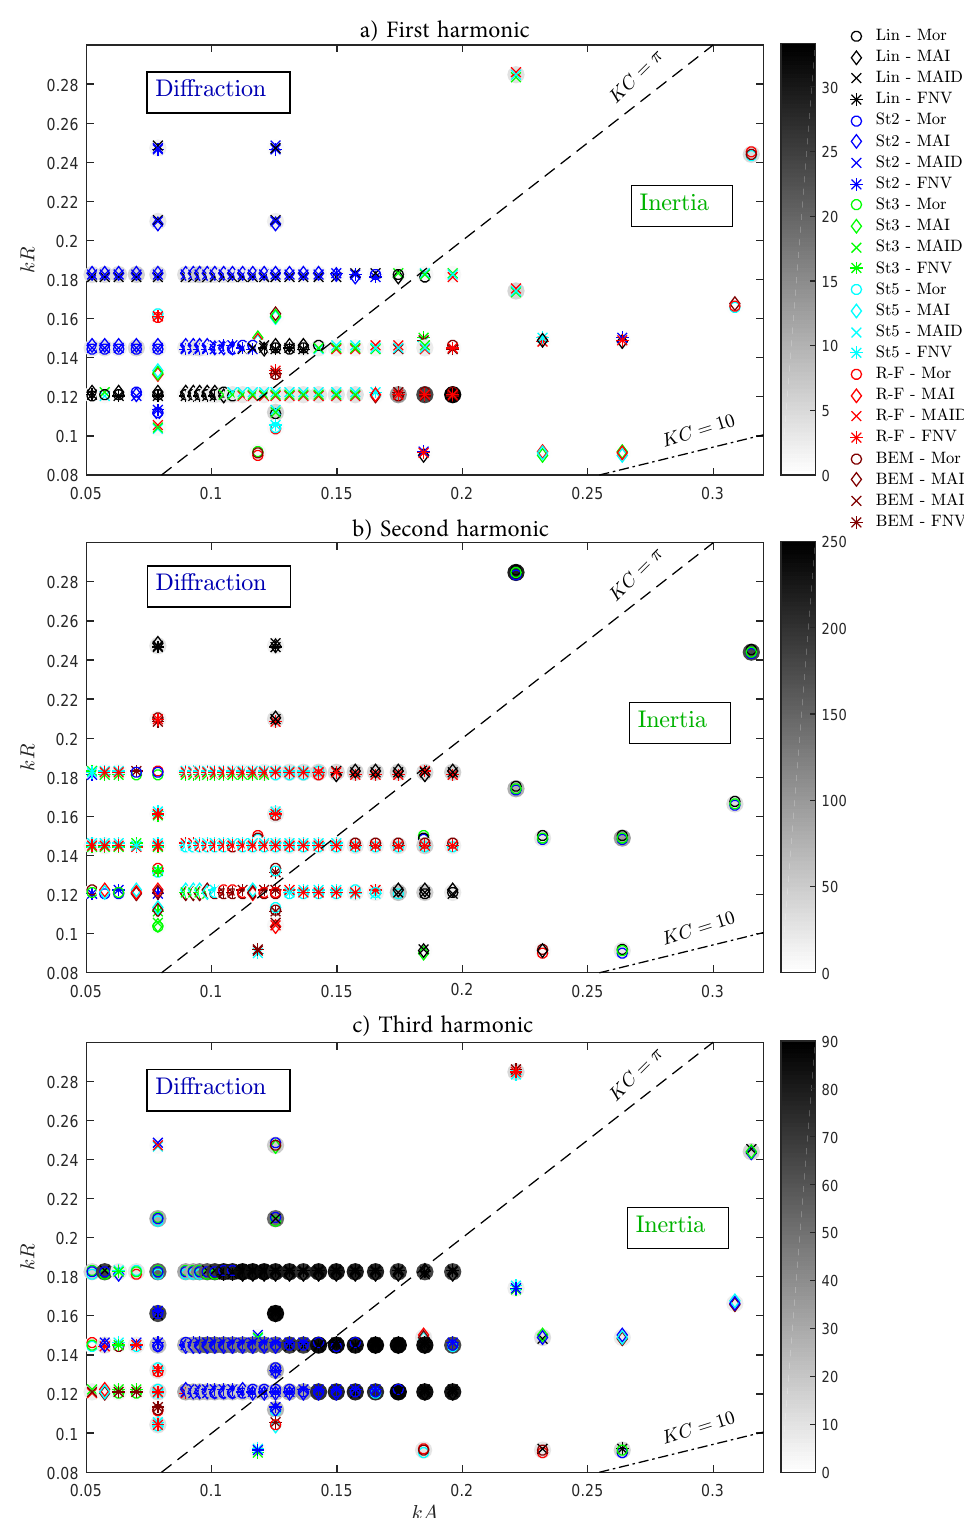
Figure 11. The best-fitting numerical models for the first ( a ), second ( b ) and third ( c ) harmonics with the intensity behind the symbol referring to the relative error (the darker—the worse the error, scale dependent on the harmonic), displayed on ( kA , kR )-grid. Marker color denotes the wave kinematics, marker symbol—hydrodynamic loading model. For reference to experiments see Figure